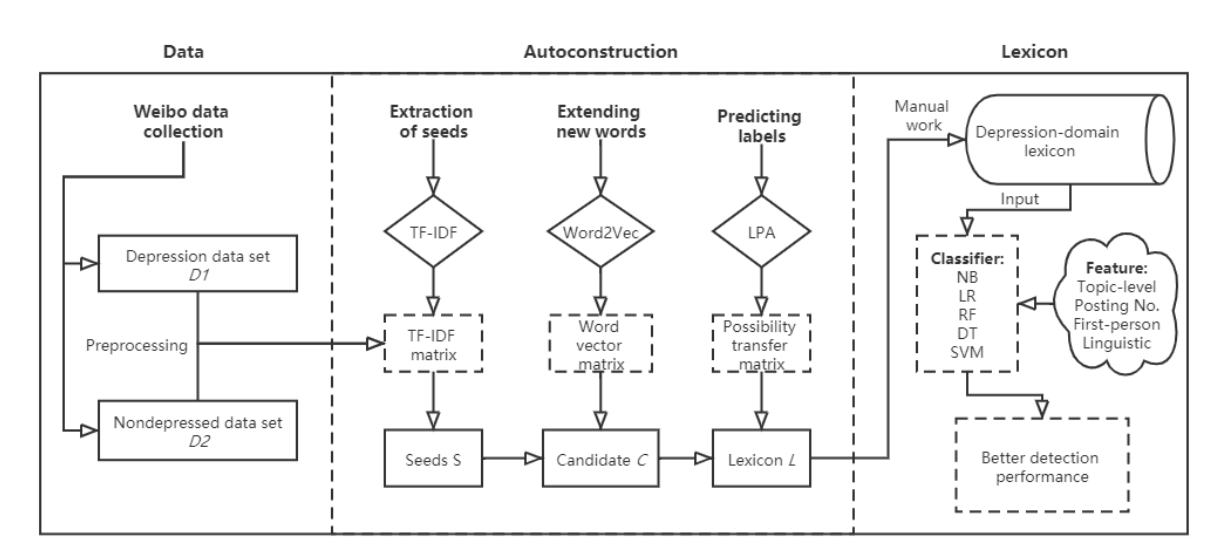
Figure 1. An illustration of the framework. DT: decision tree; LR: logistic regression; NB: naive Bayes; RF: random forest; SVM: support vector machine; TF-IDF: term frequency-inverse documentation